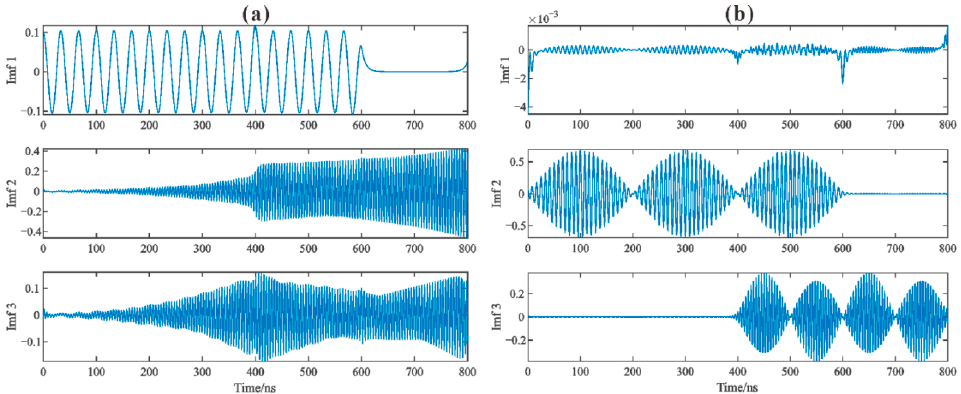
Figure 4. The VMD decomposition results for ( a ) the simulated channel-1 and ( b ) channel-2.